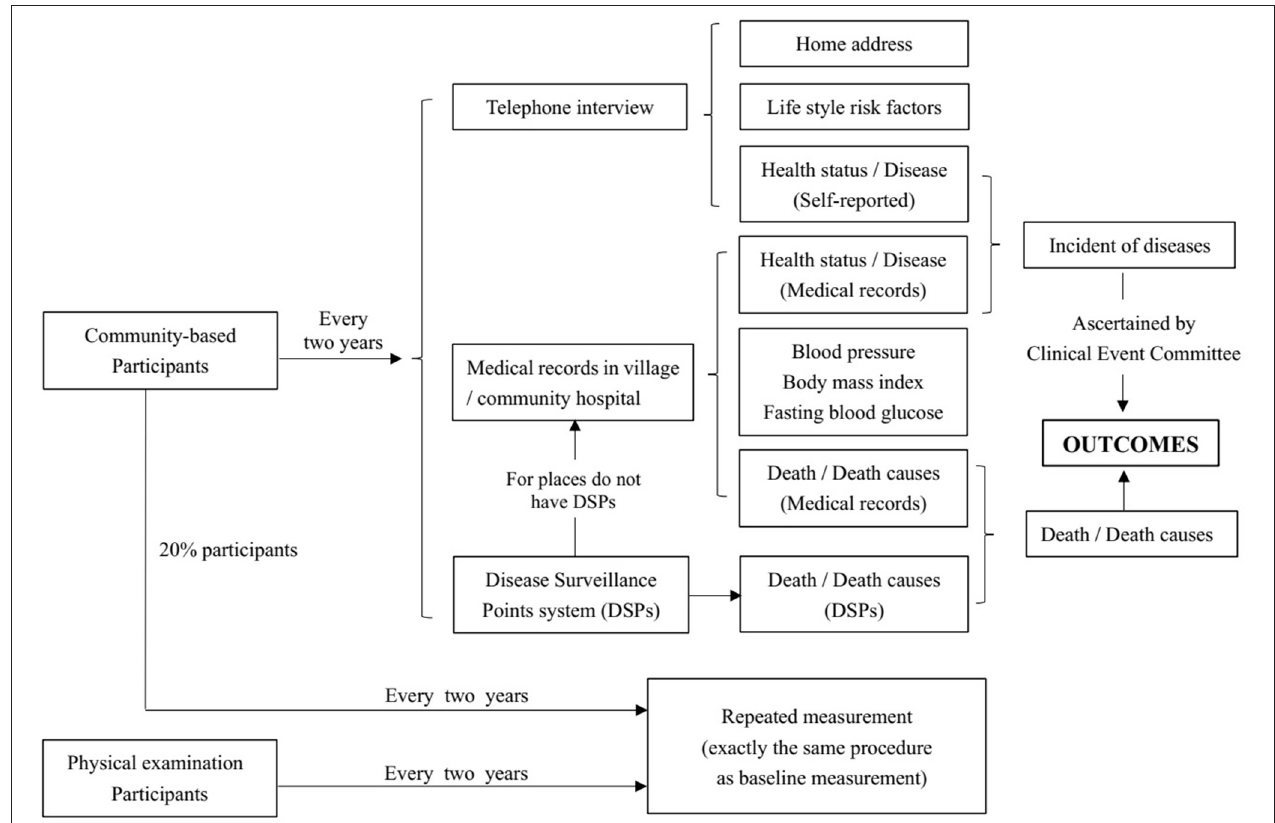
FIGURE 4 | Follow-up flow diagram in